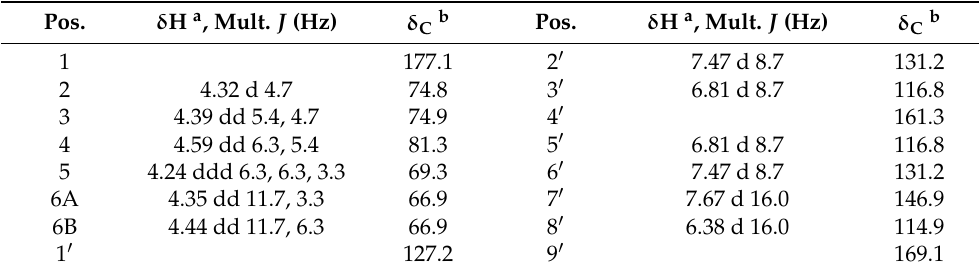
Table 3. 1 H- and 13 C-NMR data of 3 (in CD 3 OD; δ in ppm, J in Hz).